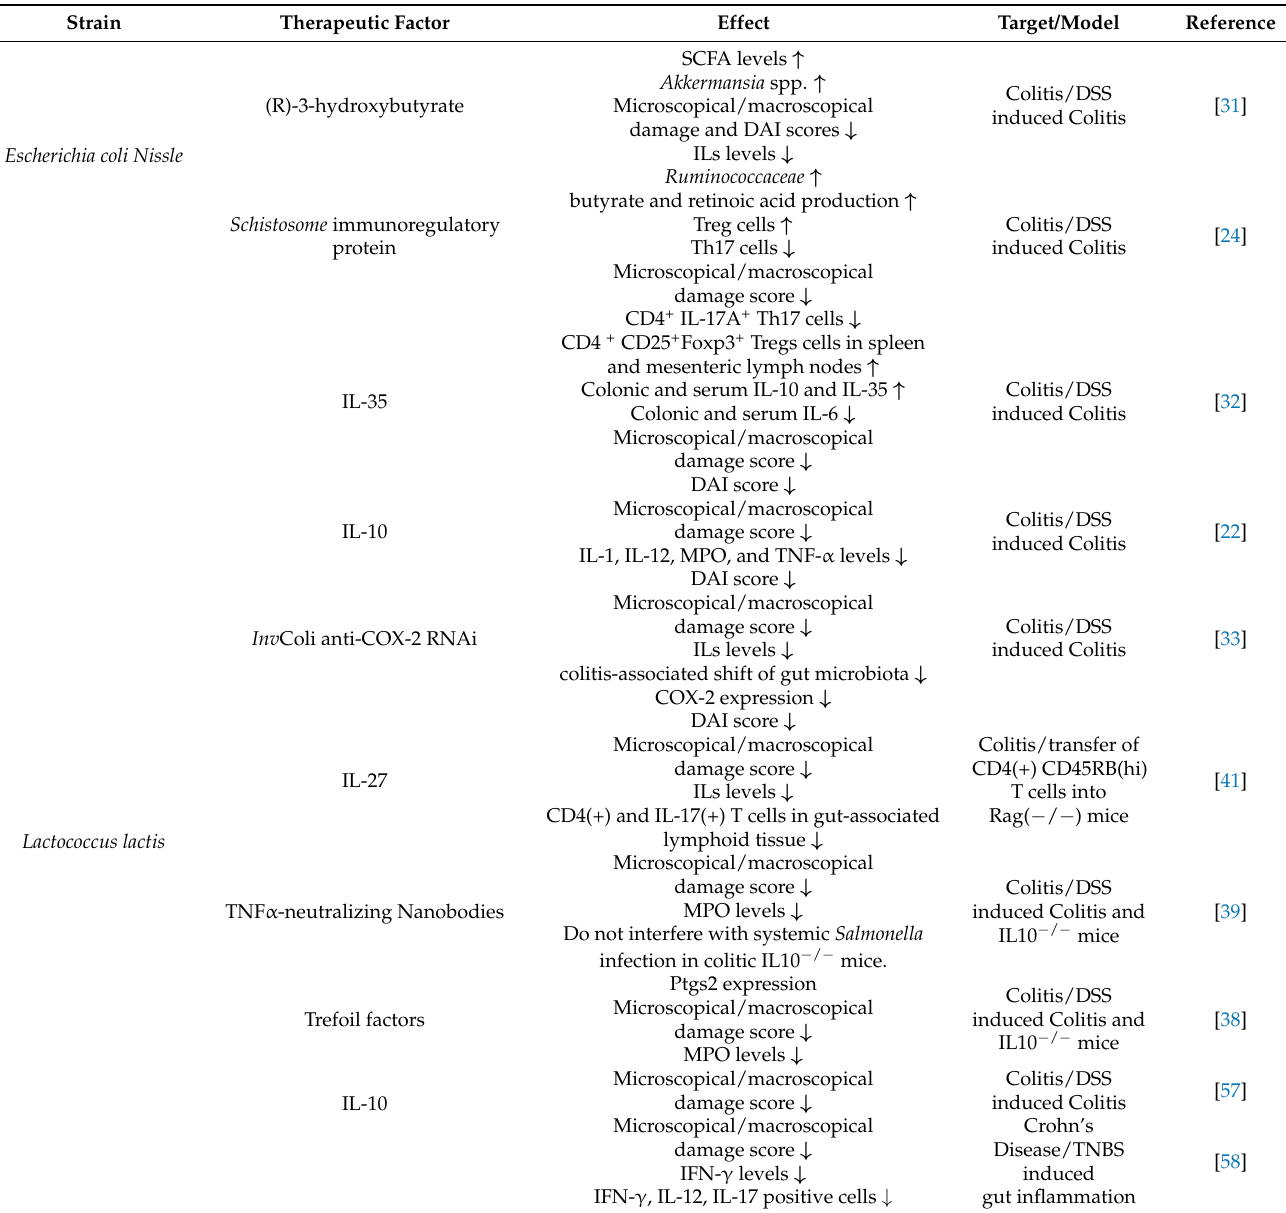
Table 1. Summarizing table of the main engineered strains for IBD